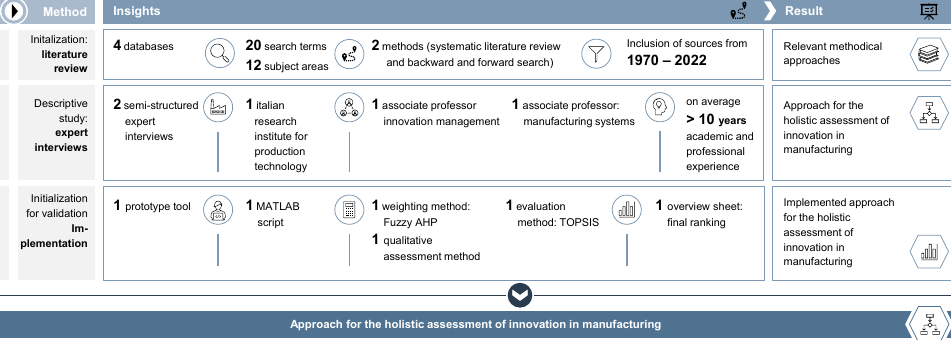
Figure 8. Overview of the approach for the holistic assessment of innovation in manufacturing. Within an industrial scenario, a finite set of alternatives will be compared by decision makers aiming to select the best initiative to undertake according to the attributes and criteria identified in Section 5.1. This kind of problem is well represented by the definition